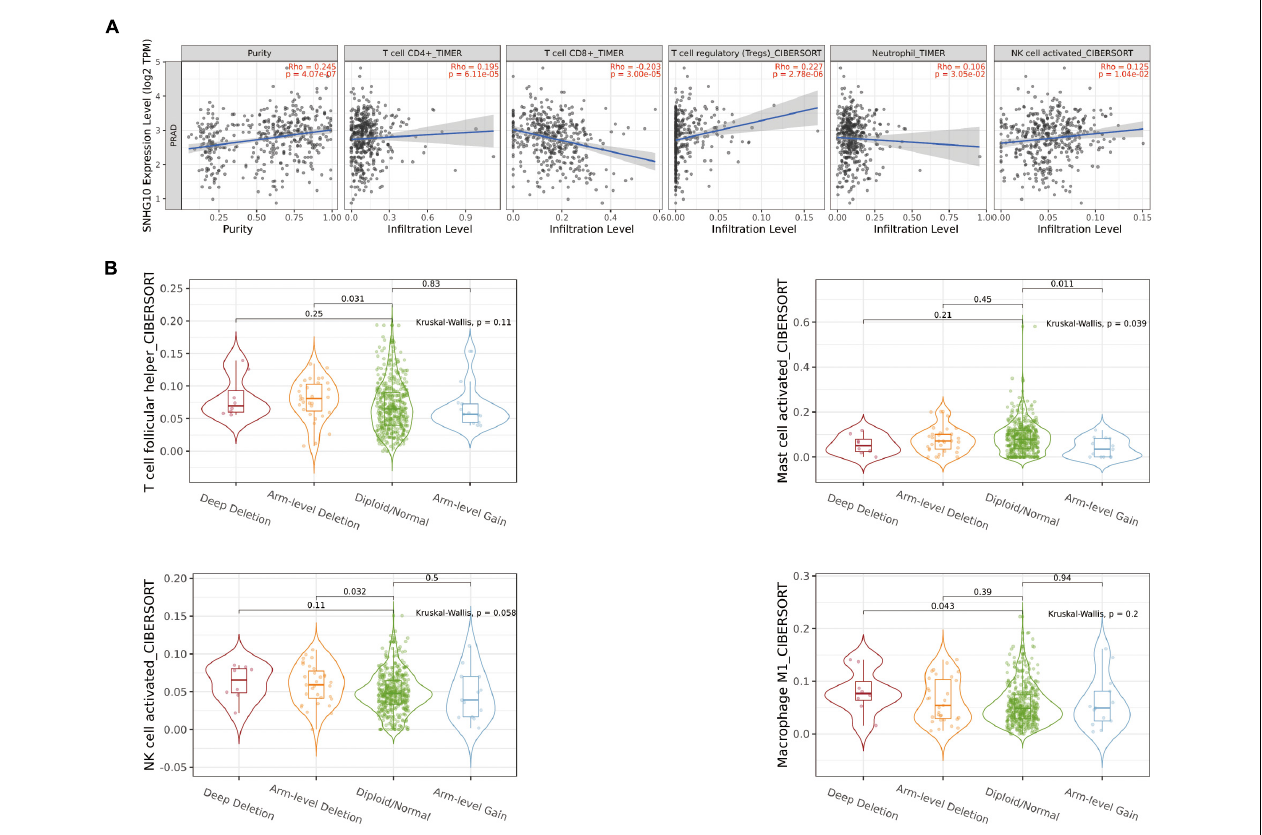
FIGURE 7 | The relationship between SNHG10 expression and tumor-infiltrated immune cells. (A) Significant correlation between SNHG10 expression and different type of immune cells. (B) Different mutational forms of SNHG10 were associated with immune infiltrates of four